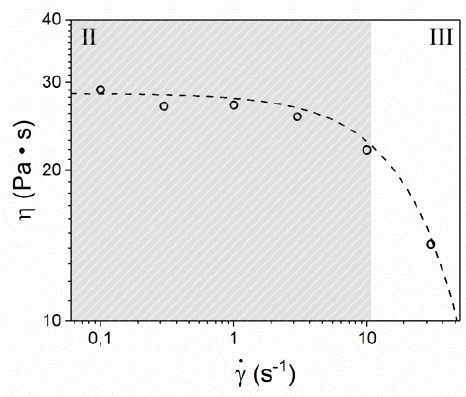
Figure 7. Steady state viscosity as a function of shear rate at 150 °C. Regime II is marked in gray. In addition to the evaluation of the steady state viscosity (Figure 7), the start-up of shear was monitored during the application of varying shear rates. This transient behavior of the LCP is depicted in Figure 8 for shear rates of 0.1, 1, and 10 s − 1 . It is well known from literature that the transient behavior of polydomain thermotropic LCPs is not only complex, but also strongly dependent on sample history and micro-structure [14,22,26,28–34,47]. It is also generally accepted that the materials response is related to the evolution of the domain texture and the interchain orientation, but the exact relations remain under discussion. The most general response of thermotropic nematic melts to the inception of shear stress involves four regimes (A–D); Regime A shows a peak in the shear stress at low strain values, followed by a minimum in shear stress, defining regime B. A second stress overshoot at large strain (regime C) is often observed before a steady state is reached (regime D). Measurements by Guo et al. on an amorphous, fully aromatic thermotropic LCP indicate that the first stress overshoot (A) and the subsequent minimum (B) correspond to stretching and break down of the domain texture at γ = 0–20, while the second overshoot (C) is related to the evolution of molecular orientation at γ = 20–300 [15,16]. Burghardt et al. found that, for a different fully aromatic LCP, the main increase in the orientation parameter obtained from WAXD occurred at considerably lower strain ( γ = 0–40), whereas the overall stress profile was similar [14]. This emphasizes the generic nature of the evolution of shear stress, but the challenge is to correlate these features to the evolution of the interchain orientation. Independent of differences in their findings regarding the interchain orientation, both authors stress the importance of sample history before the transient. In both studies qualitatively similar procedures were used, and the starting point was a polydomain structure as a result of a squeeze flow during sample loading that had been allowed to relax for some time. In-situ rheo-WAXD provides a powerful tool that can aid in the elucidation of the complex transient behavior of LCPs and the correlated structural changes. Due to their correlation with the structural evolution, the shear stress response of the LCP to the inception of shear, in combination with a controlled relaxation period, can provide information on the textural relaxation via the characteristics in the transient behavior